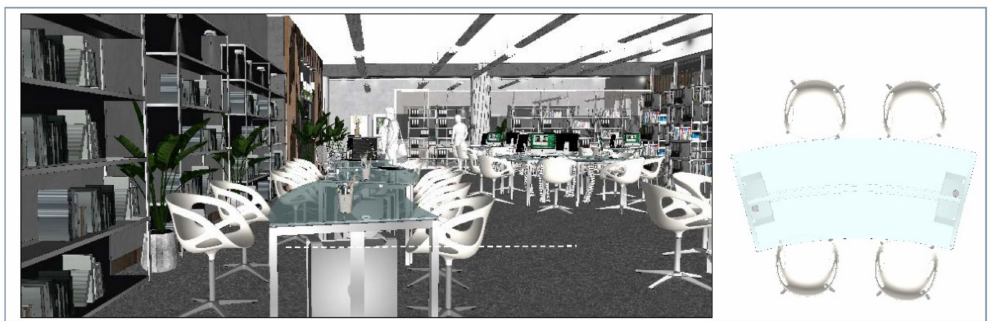
Figure 21. The current picture shows the space for reading and